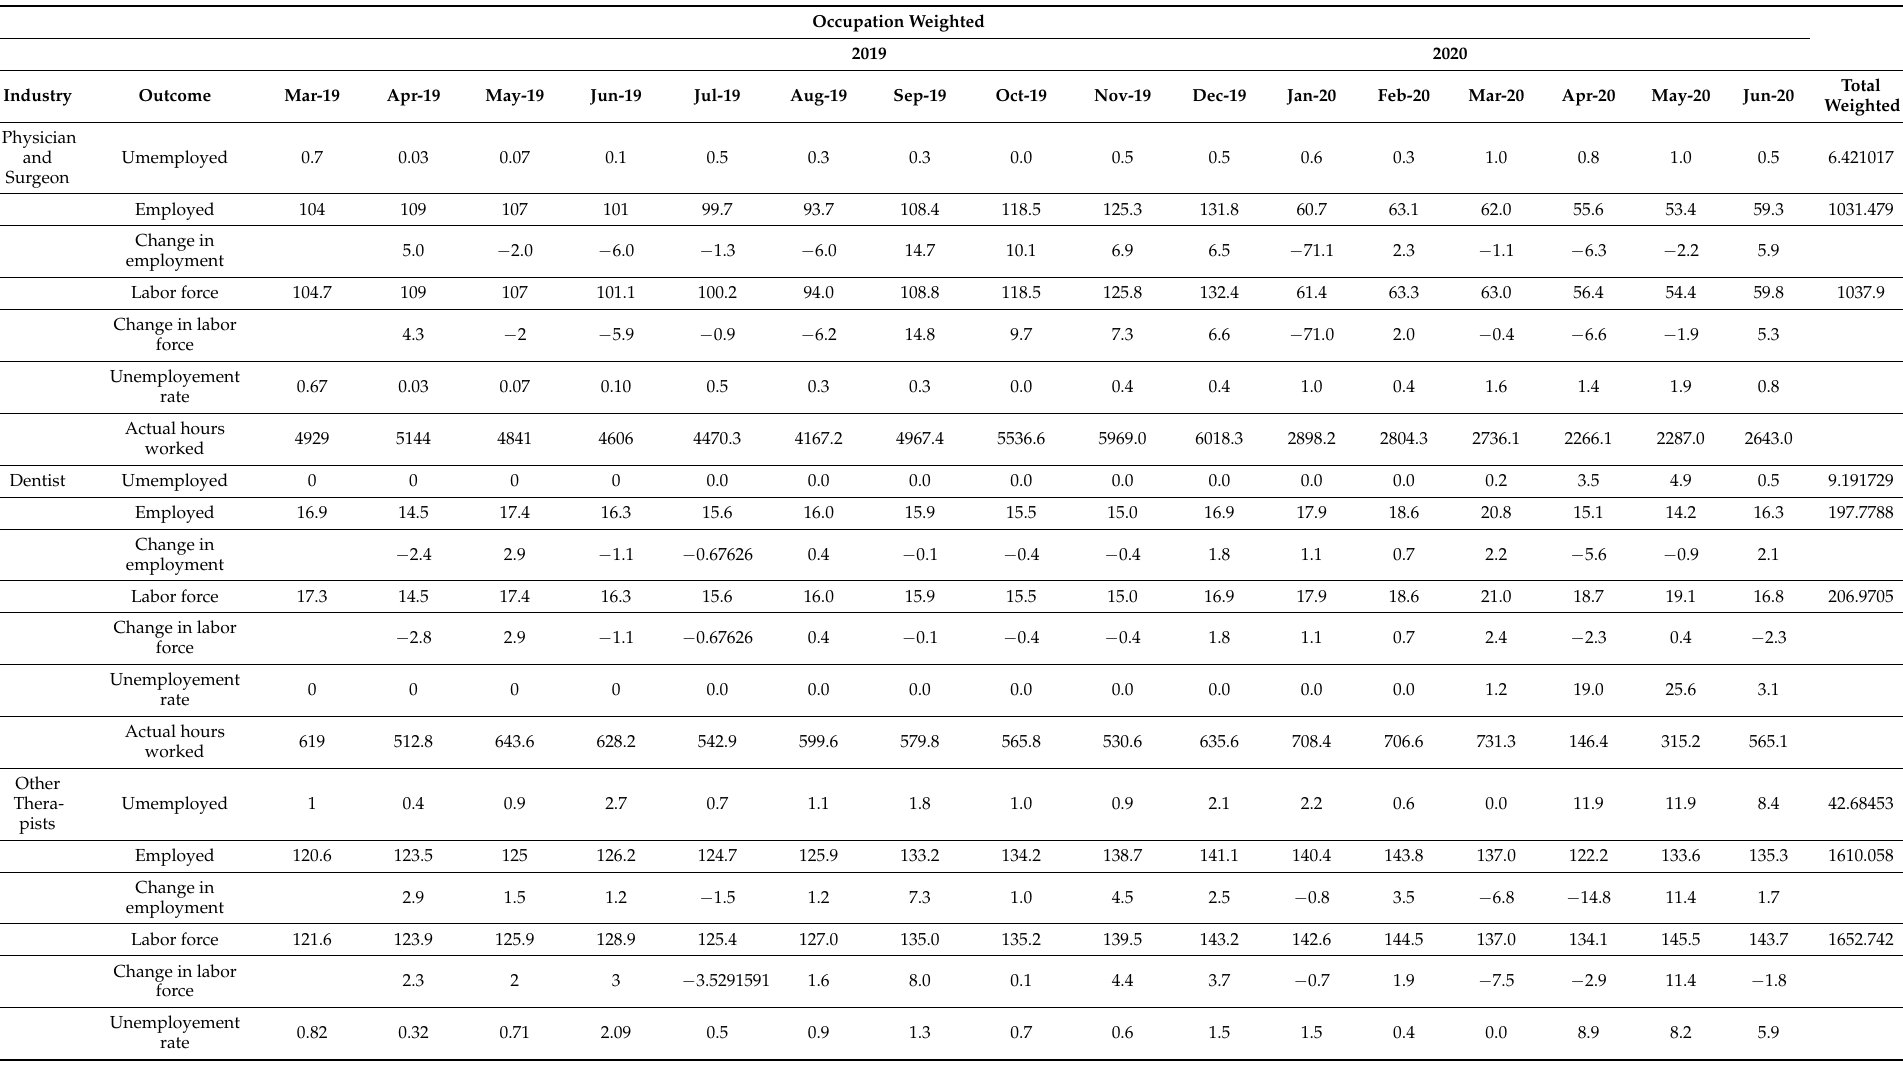
Table A2. Labor market outcomes across healthcare occupations (March 2019–June